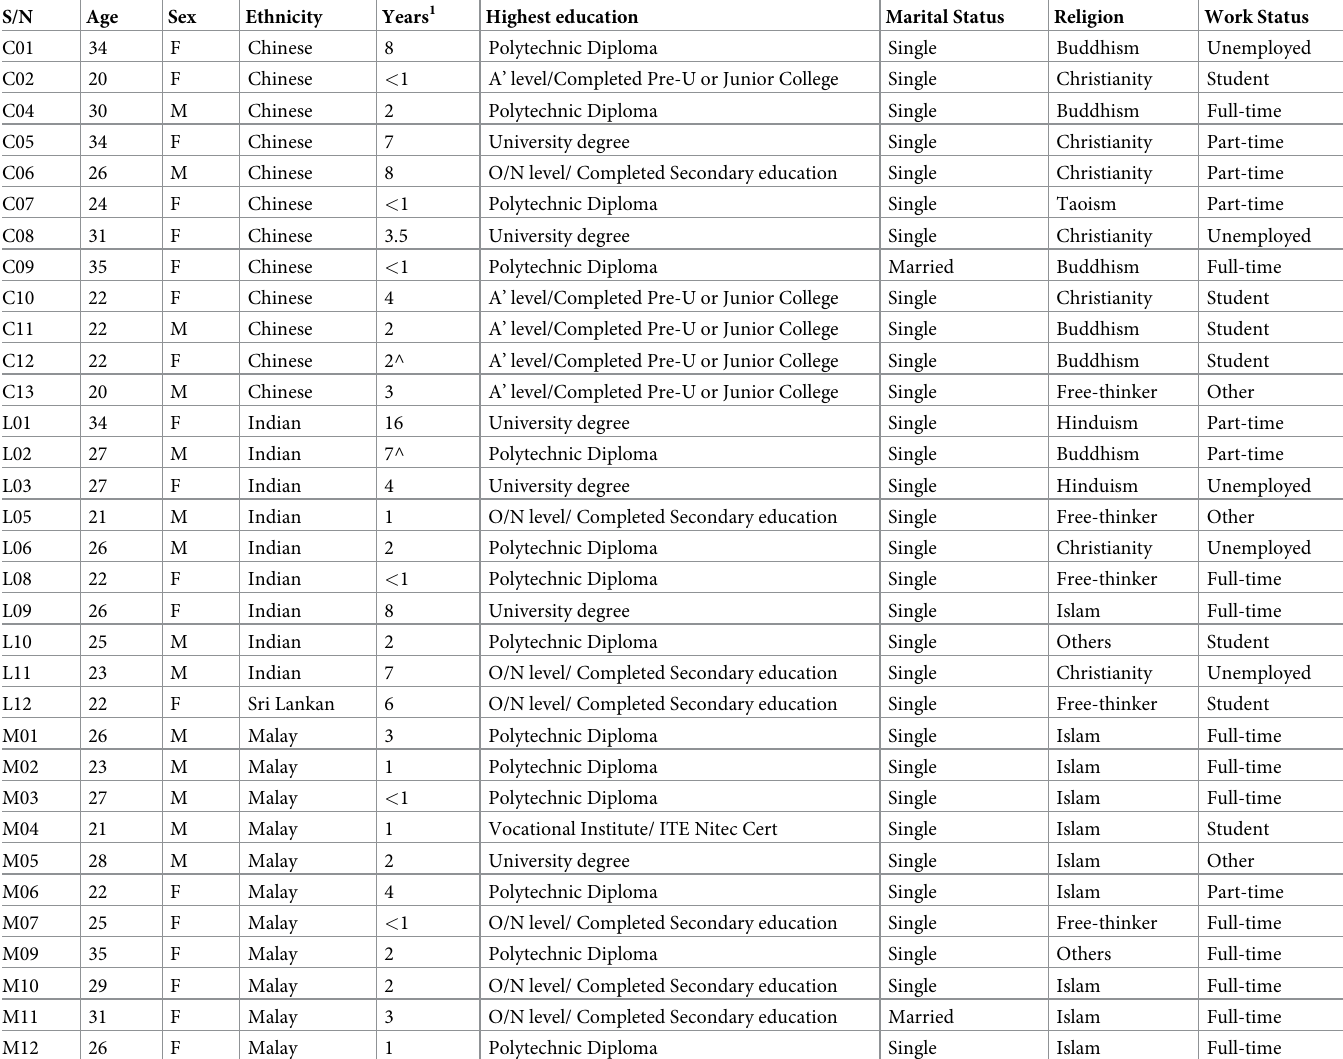
Table 1. Self-reported participant characteristics and sociodemographic information (n =